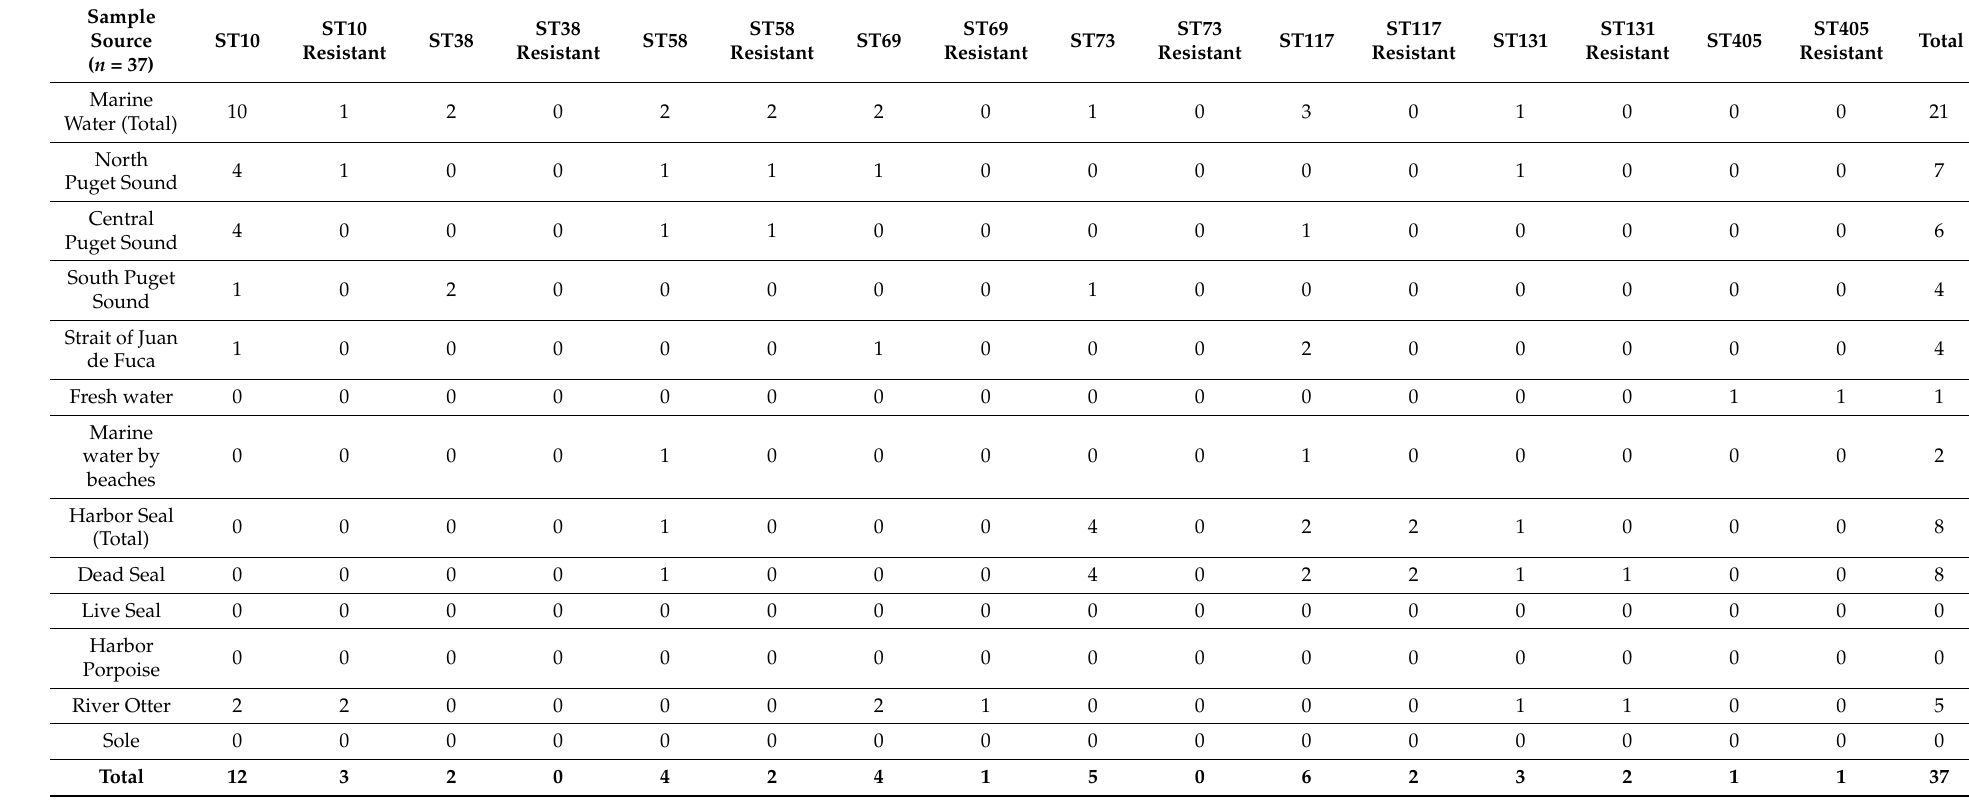
Table 3. Locations and counts of resistant isolates for each